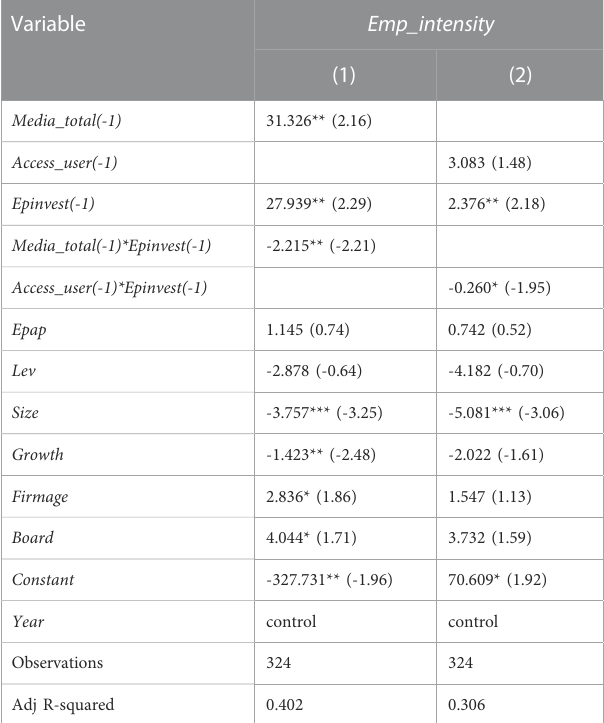
TABLE 6 Results of mechanism testing.